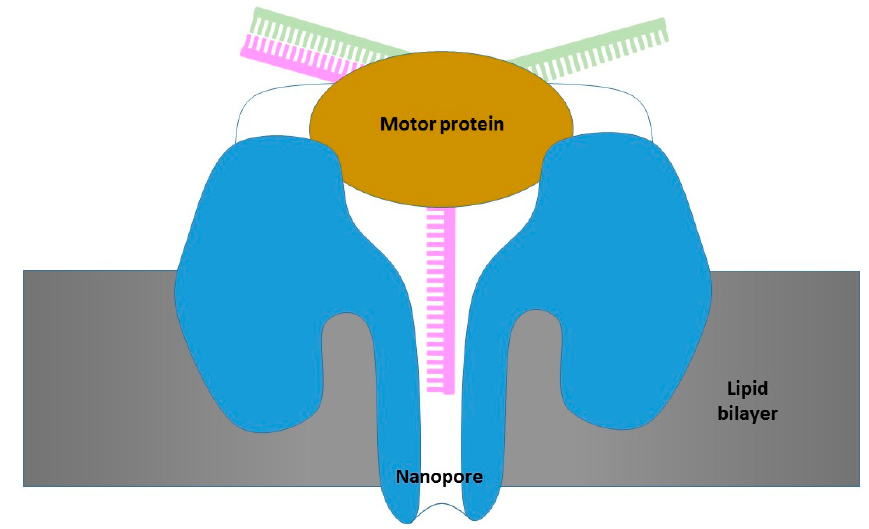
Figure 12. Channels used by the Oxford Nanopore platform to sequence DNA. The passage of DNA through the nanopore produces alterations that are measured thanks to the detected voltage changes.